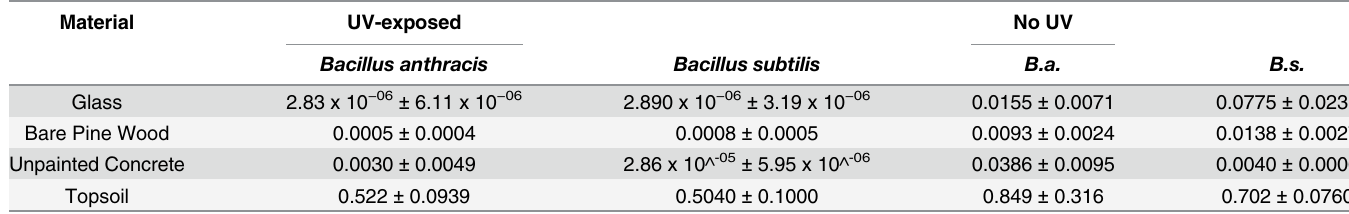
Table 4. Recovery of spores at 56 days (N 56 /N 0 ±